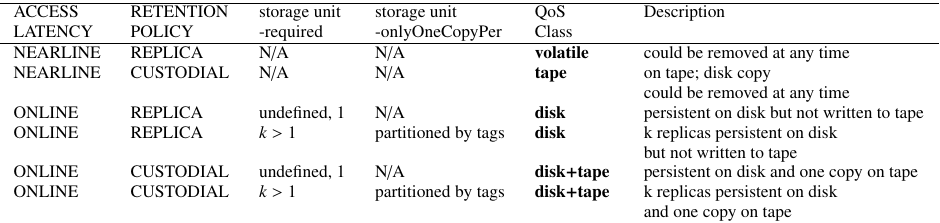
Table 1. Prototype Mapping of dCache Attributes to QoS